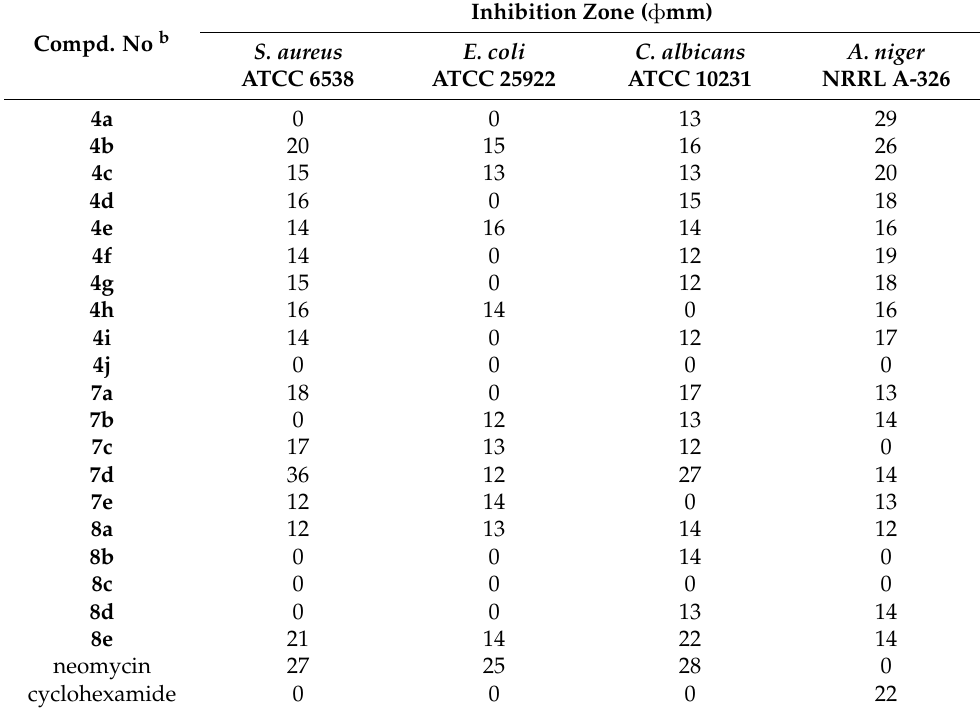
Table 1. In vitro antimicrobial activity of the new synthesized compounds against a variety of pathogenic microorganisms a